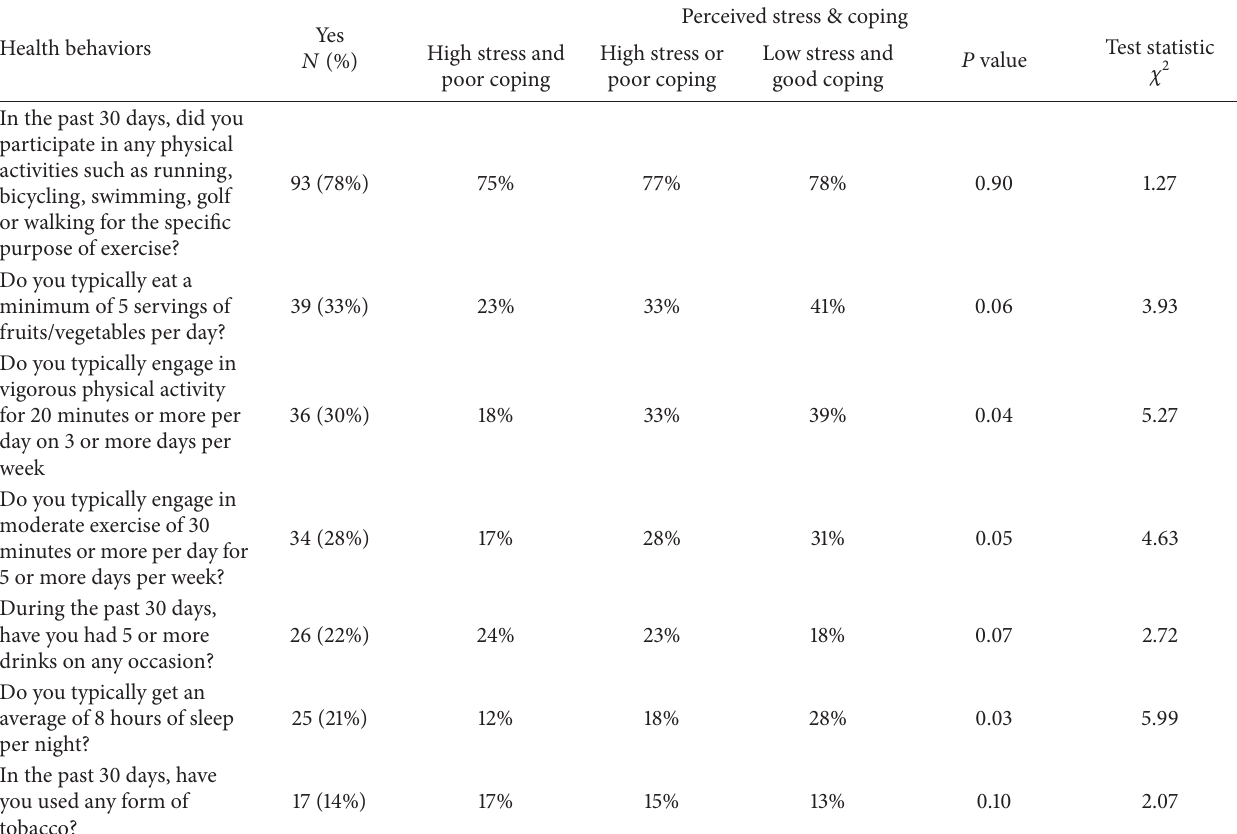
Table 4: Health behaviors of participants compared by level of stress and adequacy of coping.